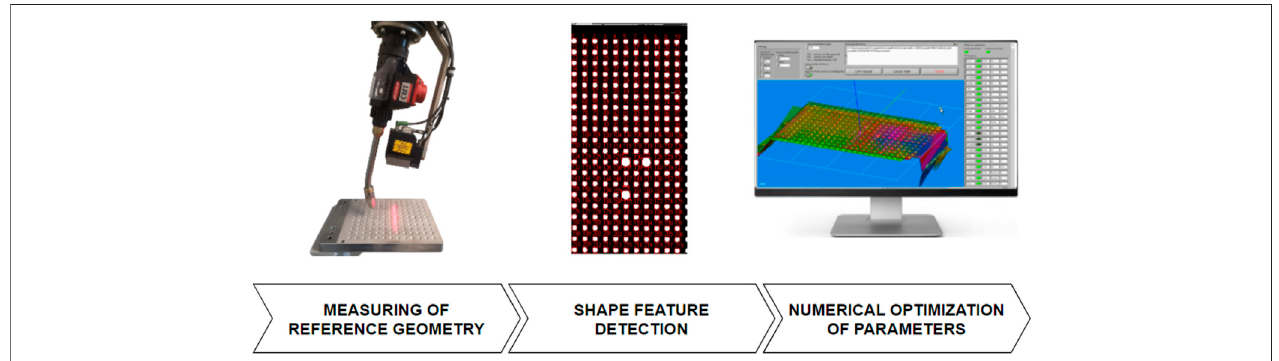
FIGURE 5 | Typical result of the system calibration. The 3D image shows the reference plate where different colors represent scans measured from various poses (15 in total). The table shows statistics of the fi nal deviations of the reference points in each direction.